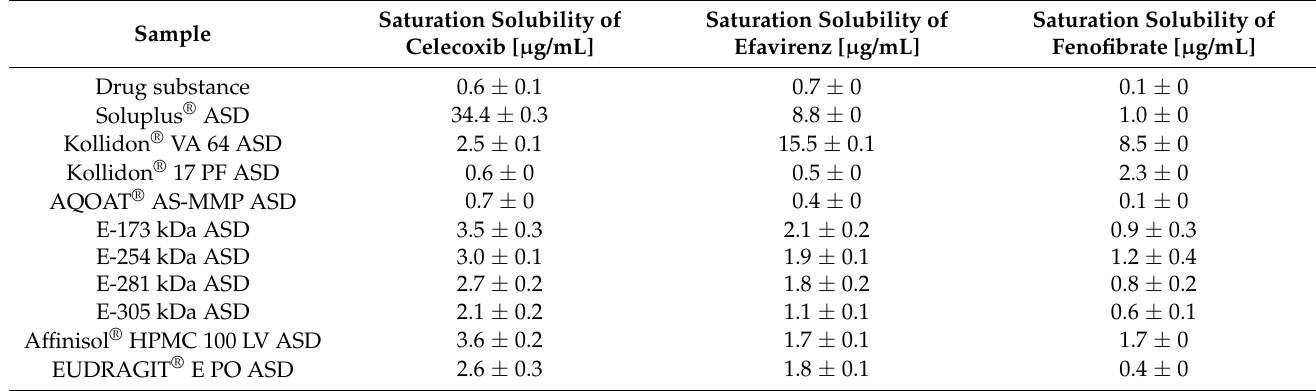
Table 7. Saturation solubility (48 h) of celecoxib, efavirenz, and fenofibrate pure drugs and ASDs in water at 20 ◦ C. Each value designates the mean ± S.D. (n = 3).